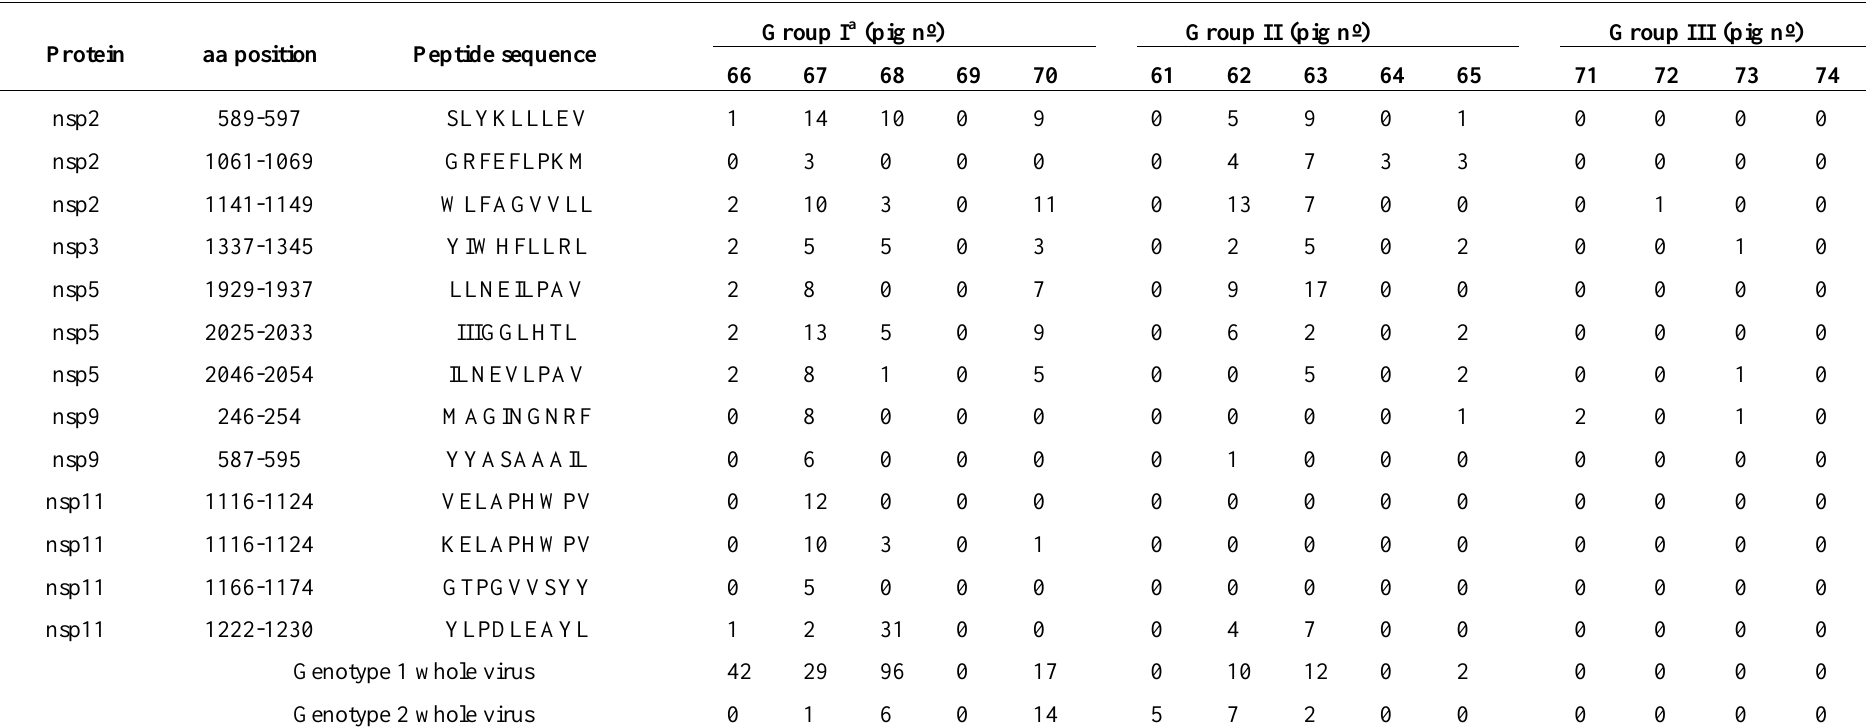
Table 2. Frequencies of IFN-γ secreting cells per 5 × 10 5 PBMC (ELISPOT) induced by peptides of non-structural proteins of PRRSV. The table shows only peptides resulting in an adjusted count of at least ≥5 spots/well (cut-off of the test) for one or more